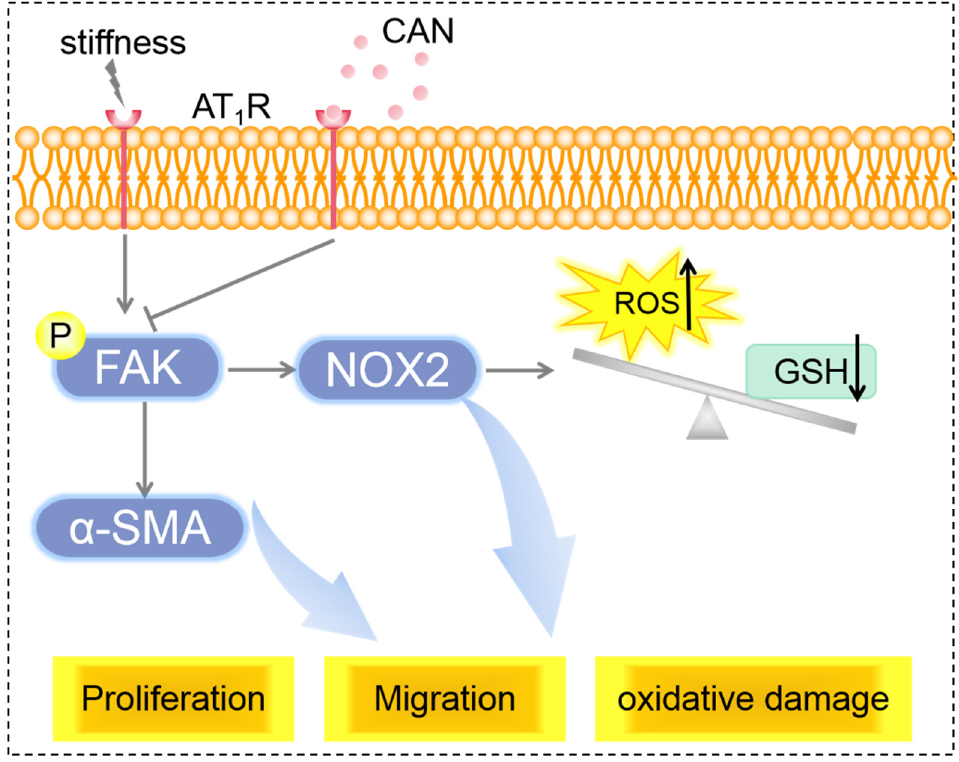
Figure 10. Scheme of mechanisms of ECM stiffness effect on CAN efficacy in myocardial fibrosis.